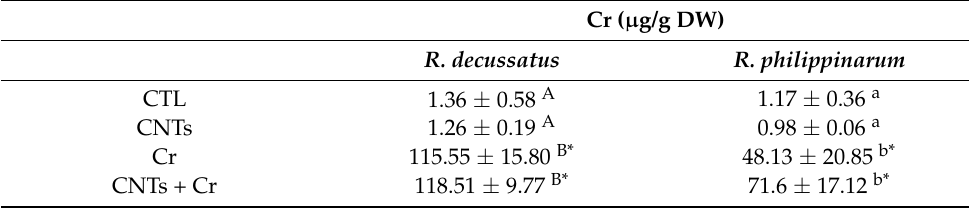
Table 3. Chromium (Cr) concentrations in clams ( µ g/g dry weight (DW)) collected at the end of the experimental period (28 days) and in each tested treatment. Significant differences ( p < 0.05) among exposure treatments were presented with different letters (uppercase letters for R. decussatus and lowercase letters for R. philippinarum ) and between species with asterisks (*). Values correspond to 3 clam samples per aquarium ± standard